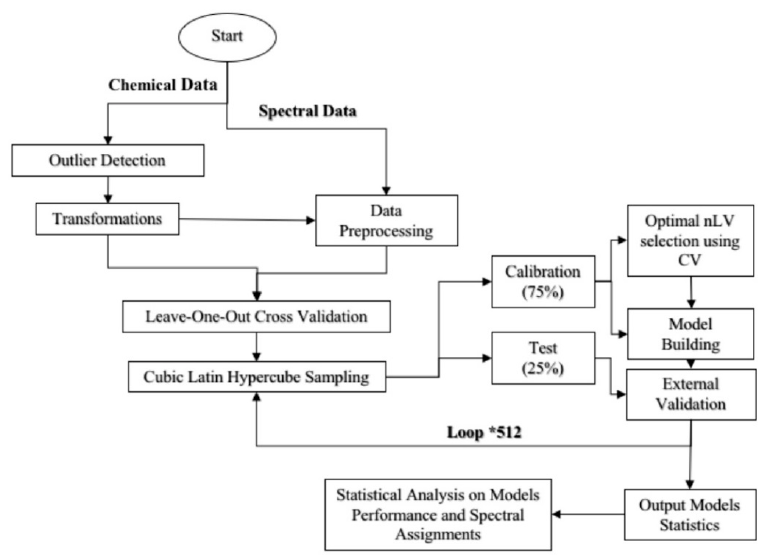
Figure 2. PARACUDA-II ® processing Figure 2. PARACUDA ‐ II ® processing framework.